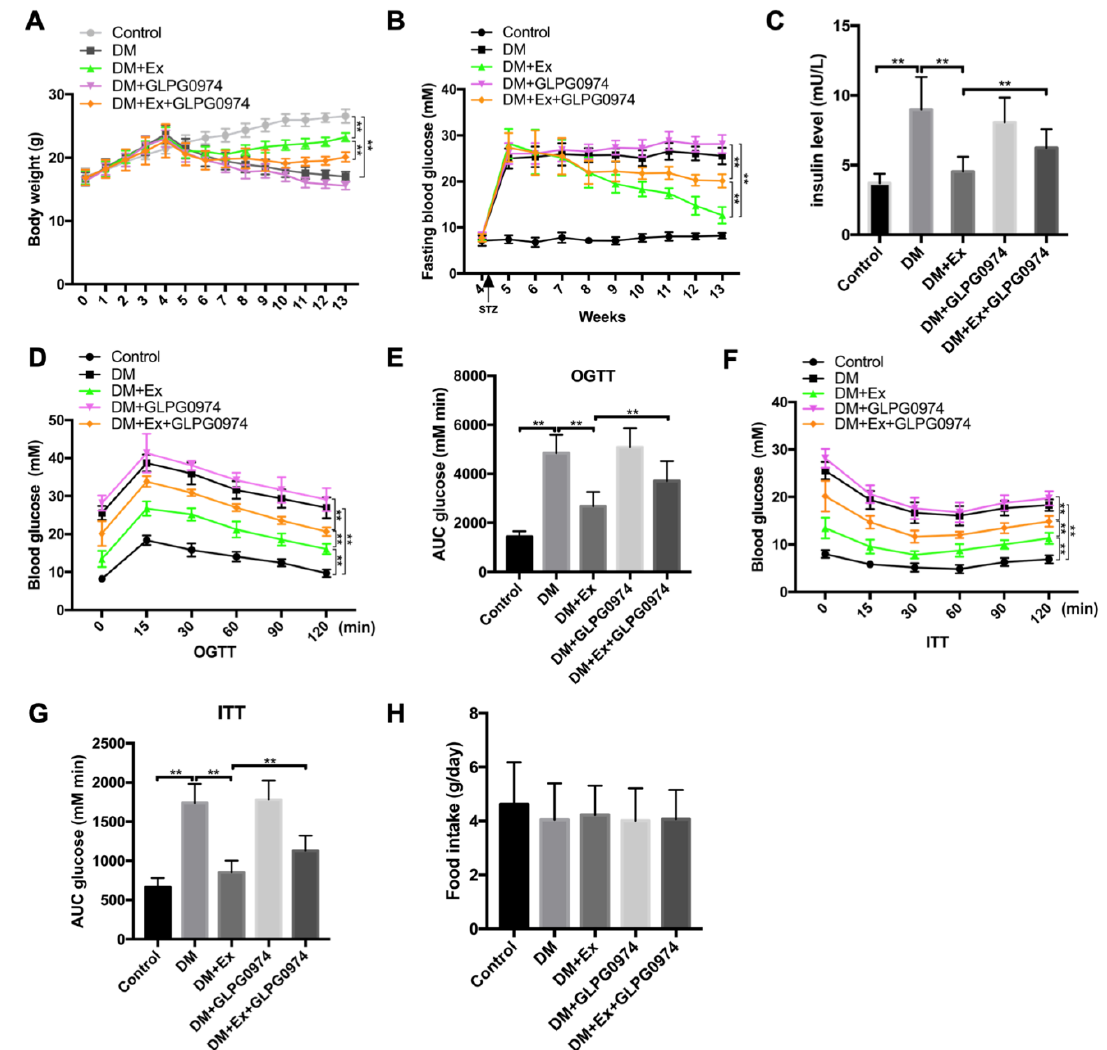
Figure 3. GPR43 antagonist inhibits the improvement of DM symptoms by exercise. ( A ) After the T2DM model was established, all diabetic mice were challenged with GLPG0974 and the body weight of mice in each group was measured; ( B ) fasting blood glucose in each group were determined by a OneTouch Ultra blood glucose meter; ( C ) insulin levels in mice of each group as detected by ELISA kit; ( D ) fasting blood glucose was performed after glucose administration for 15, 30, 60, 90 and 120 min and the curve of oral glucose tolerance test (OGTT) was made; ( E ) area under glucose tolerance curve in each group; ( F ) fasting blood glucose level was determined after insulin injection for 15, 30, 60, 90 and 120 min and a tolerance test (ITT) was created; ( G ) area under the insulin tolerance curve in different groups; ( H ) food intake in control mice, diabetic mice treated with or without exercise and diabetic mice treated with or without GLPG0974. ** p < 0.01.